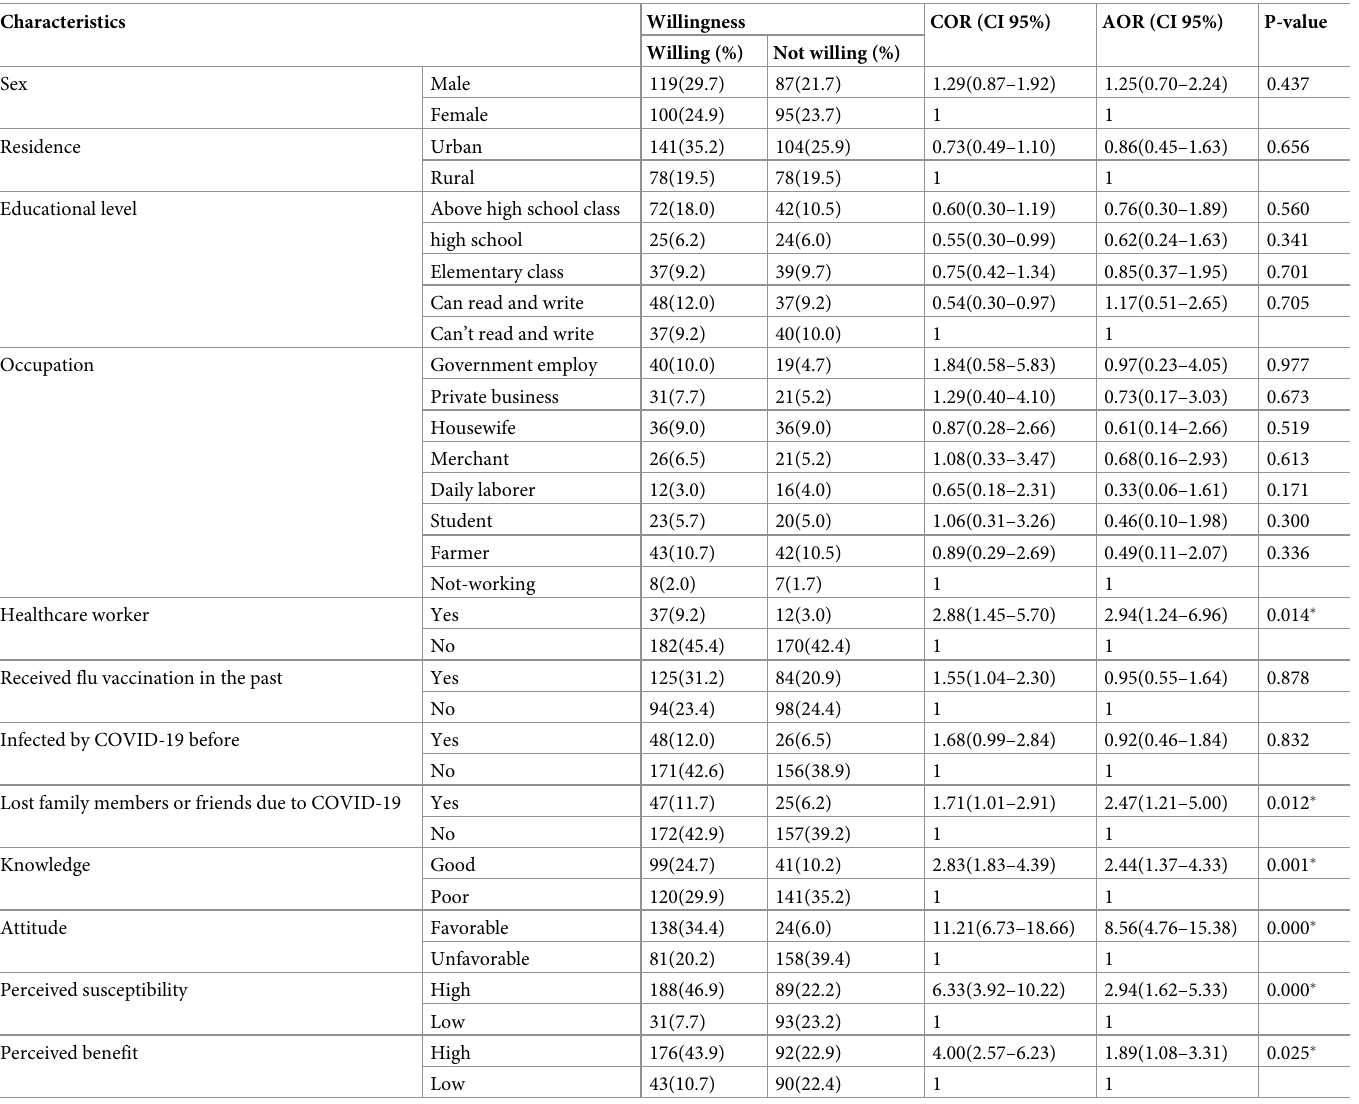
Table 5. Factors associated with chronic patients’ willingness to take COVID-19 vaccination (N = 401).